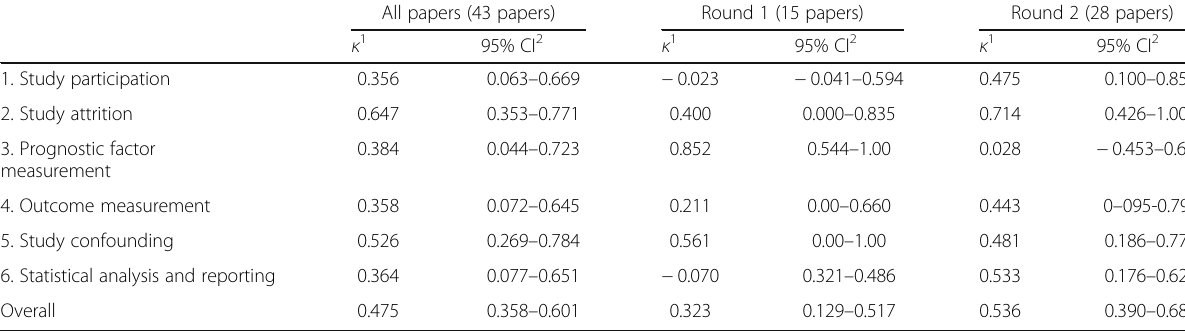
Table 2 Interrater agreement for all papers and for the two rounds separately All papers (43 papers) Round 1 (15